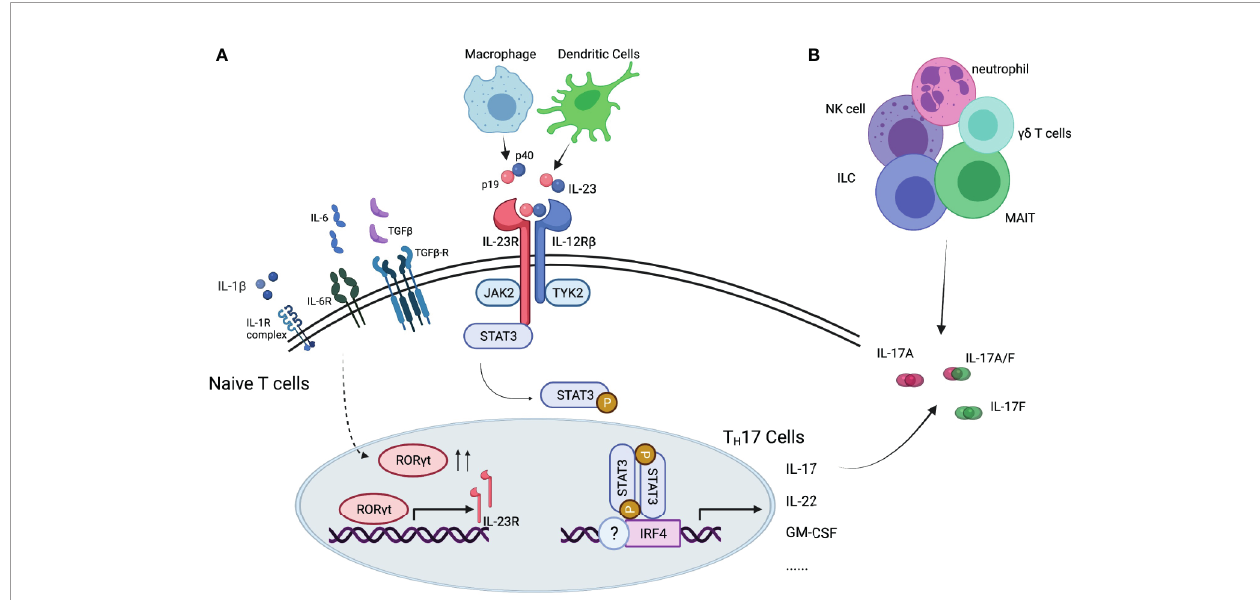
FIGURE 1 | Interleukin-23/interleukin-17 pathway. (A) IL-23 is essential for differentiation of T H 17 cells and production of IL-17 cytokine. (B) IL-17 cytokine can be produced by other immune cells. IL, interleukin; IL-23R, interleukin-23 receptor; IL-12R b , interleukin-12 receptor beta; IL-6R, interleukin-6 receptor; TGF b , transforming growth factor beta; TGF b -R, transforming growth factor beta receptor; IL-1R, interleukin-1 receptor; JAK2, Janus kinase 2; TYK2, tyrosine kinase 2; ROR g t, retinoid-related orphan receptor gamma t; receptor- STAT3, signal transducer and activator of transcription 3; IRF4, interferon regulatory factor 4; NK cell, natural killer cell; ILC, innate lymphoid cell; MAIT, mucosal associated invariant T